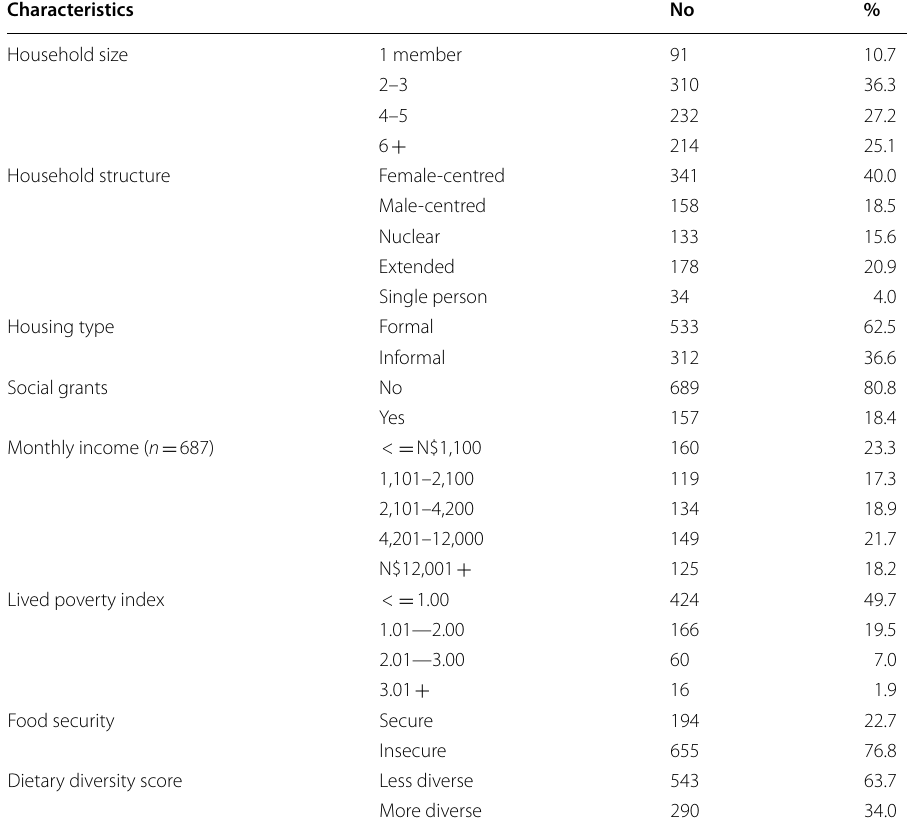
Table 3 Household variables ( n